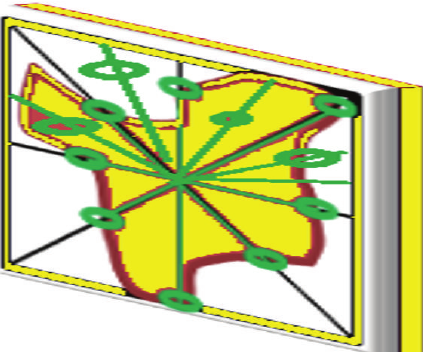
Figure 4: Three-dimensional directions drawn towards a